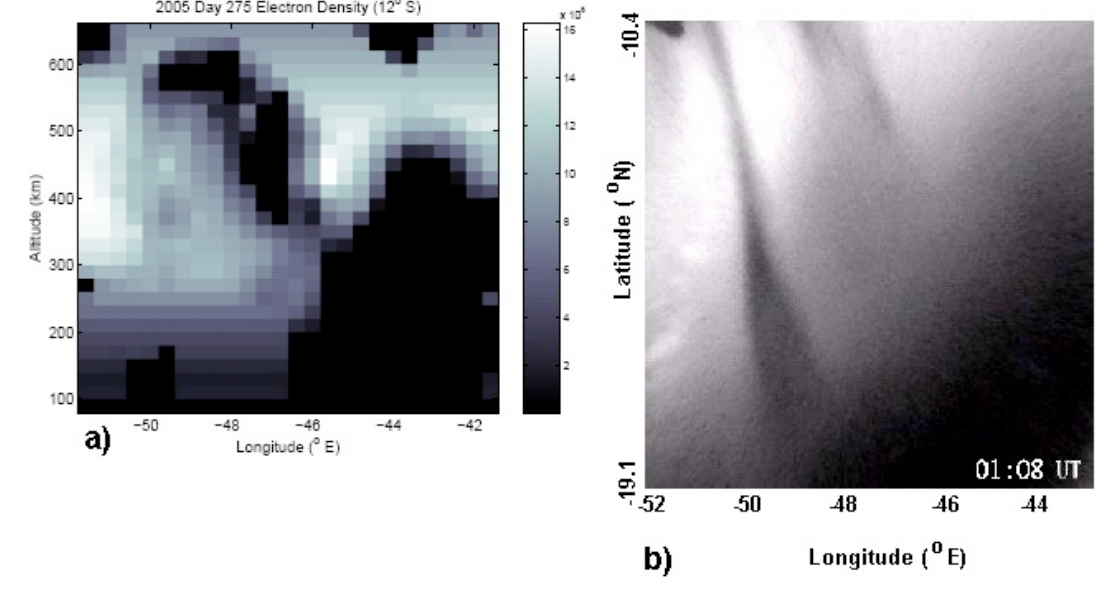
Fig. 6. Comparison of GUVI reconstruction (left) and redline airglow imager (right) for Day 275, 2005.